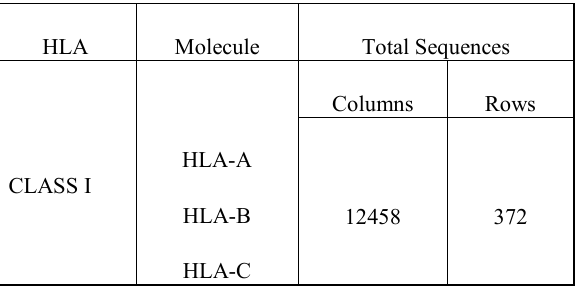
Table 2. HLA protein